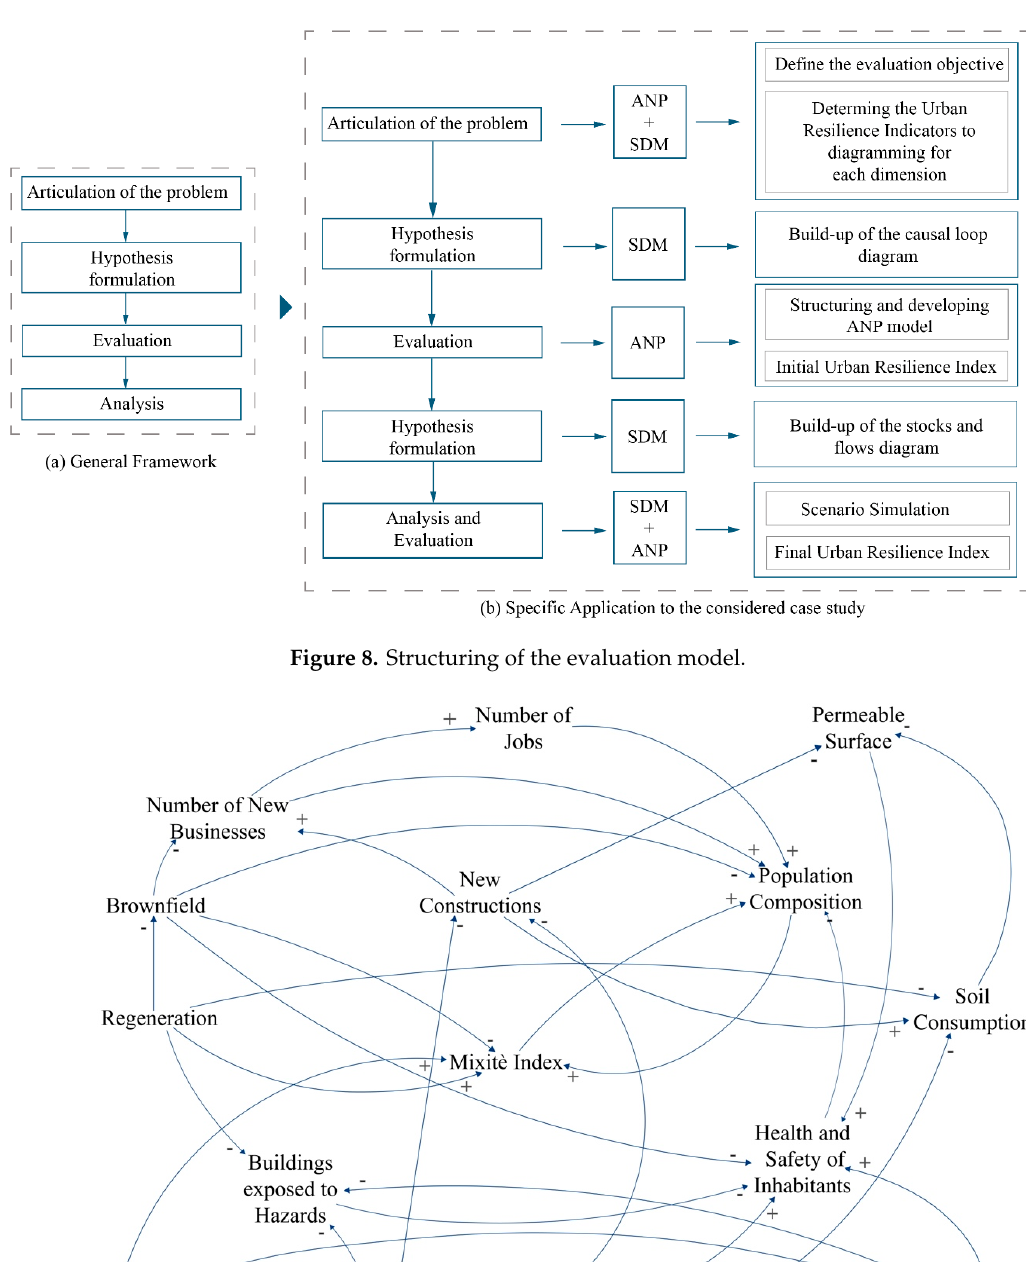
Table 2. Urban Resilience variables for the SDM (Datola et al., 2019).